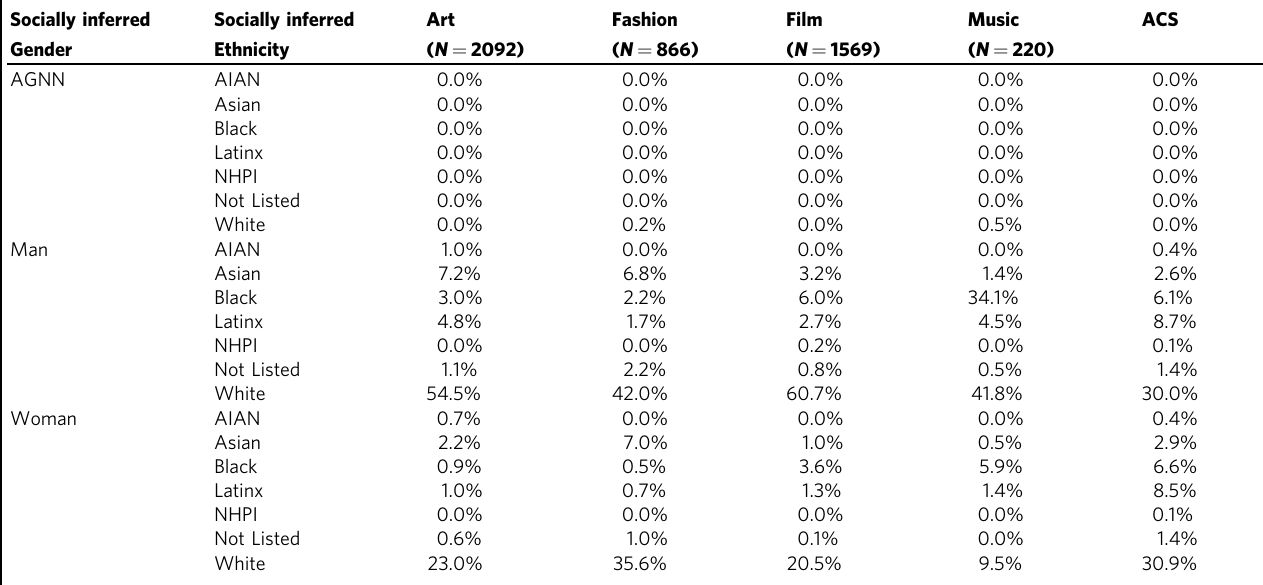
Table 1 Socially inferred gender and race/ethnicity in four creative domains: contemporary art, high fashion, box of fi ce fi lm, and popular music, as obtained through the process described in section “ Methodology. ” Socially inferred Socially inferred